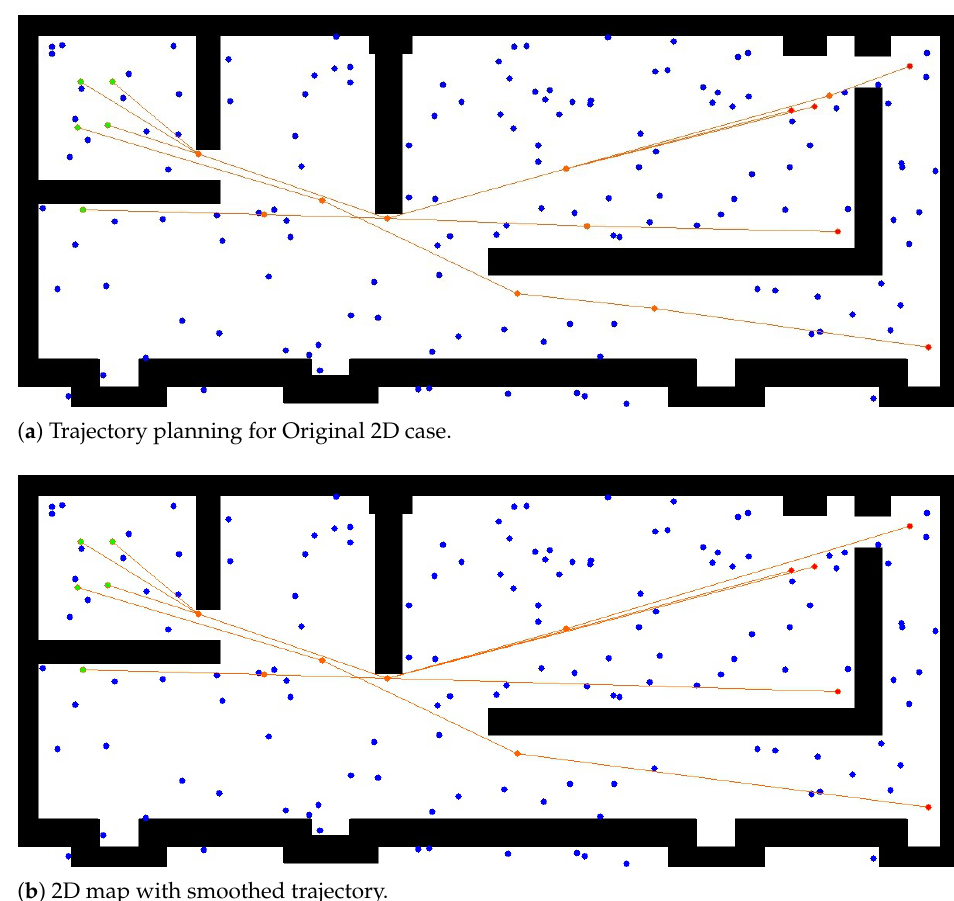
Figure 5. Example of 2D path